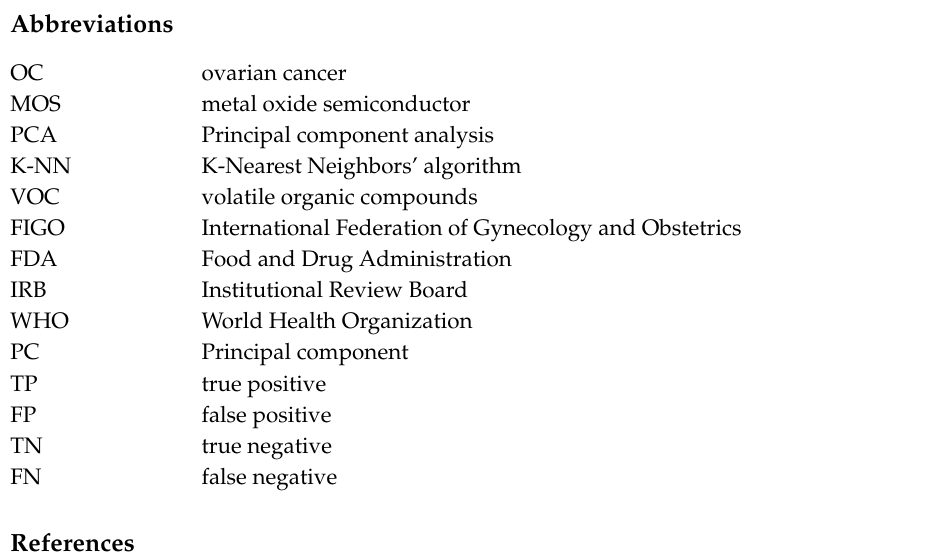
Figure S1: The impact of tumor size on e-nose signals, Figure S2: The impact of histology on e-nose signals, Table S1: Baseline patients’ characteristics, Table S2: Final histological diagnosis for patients with adnexal masses who had surgery, Table S3: Generic confusion matrix identifying true positive (TP), false positive (FP), true negative (TN), false negative (FN) and the reference equation to calculate sensitivity (SENS) and specificity